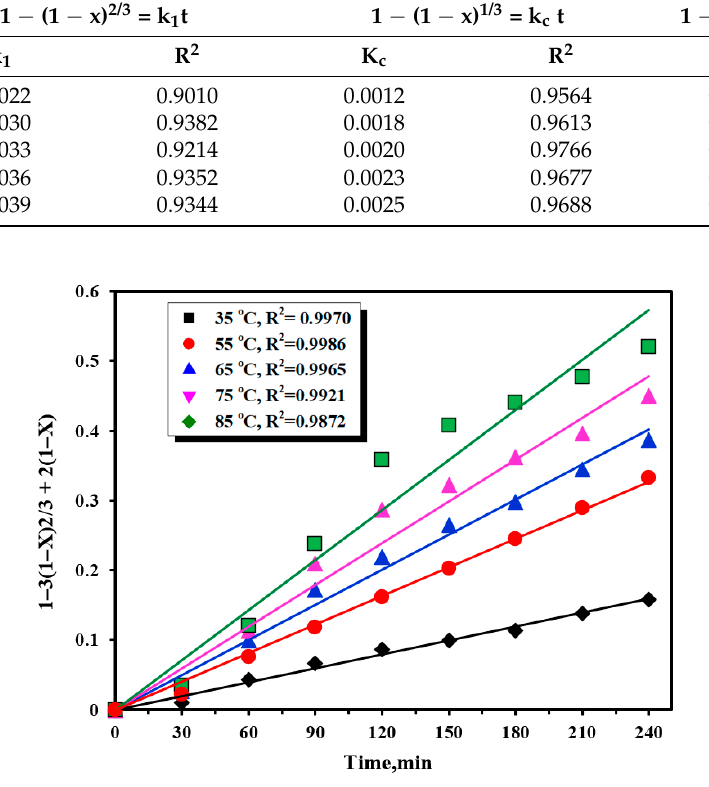
Figure 19. Plot of 1 – 3(1 – x) 2/3 + 2(1 – x) vs. time at different temperature.